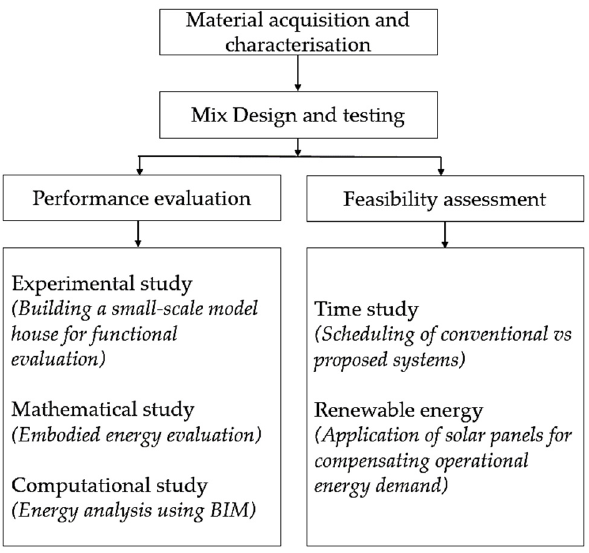
Figure 4. Workflow